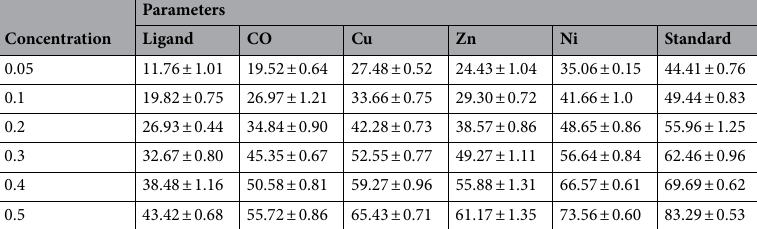
Table 6. The effect of ligand and its complexes on antioxidant RBCs at different concentrations (0.05–0. 5 mg/ mL).